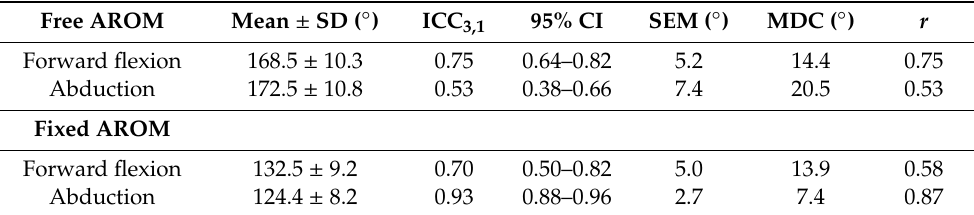
Table 3. Intra-reliability and Pearson’s r (Goniometry) of rater A ( n = 50).